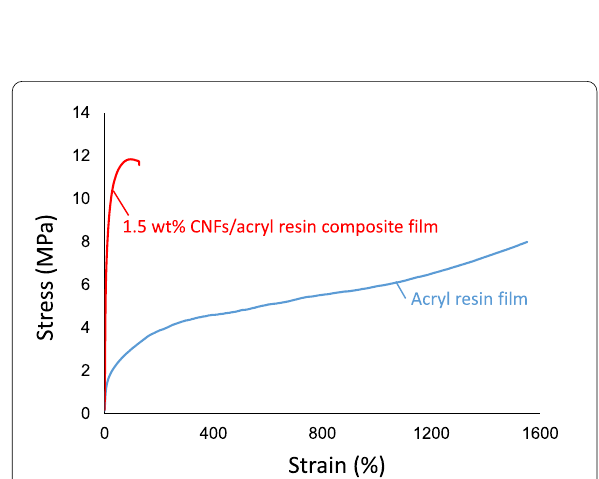
Fig. 5 Stress–strain curves of the acryl resin and CNFs/acryl resin composite film. Typical stress–strain curve of each one of the four or five specimens is shown